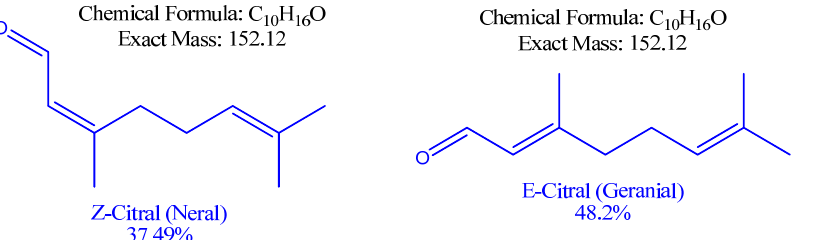
Figure 2. Chemical structure of neral and geranial as the major constituents of Egyptian C. citratus EO. The antifungal activities of C. citratus and C. proximus EOs obtained by the broth microdilution method are reported in Table 3. The minimal inhibitory concentration (MIC) and the minimal fungicidal concentration (MFC) values vary according to the EO’s origin. The MIC and MFC values of C. citratus EO were lower (MIC values from 1.25 to 5 µ L/mL) than those registered for C. proximus EO (MIC values from 2.5 to 20 µ L/mL). The M. furfur strains were the most sensitive species to both EOs. Among Candida spp., C. catenulata and C. guilliermondii were less sensitive to C. citratus EO. Table 3. Minimum inhibitory concentration (MIC) and minimum fungicidal concentration (MFC) of Cymbopogon citratus and Cymbopogon proximus EOs and fluconazole (FLZ) against Candida spp. and Malassezia furfur .